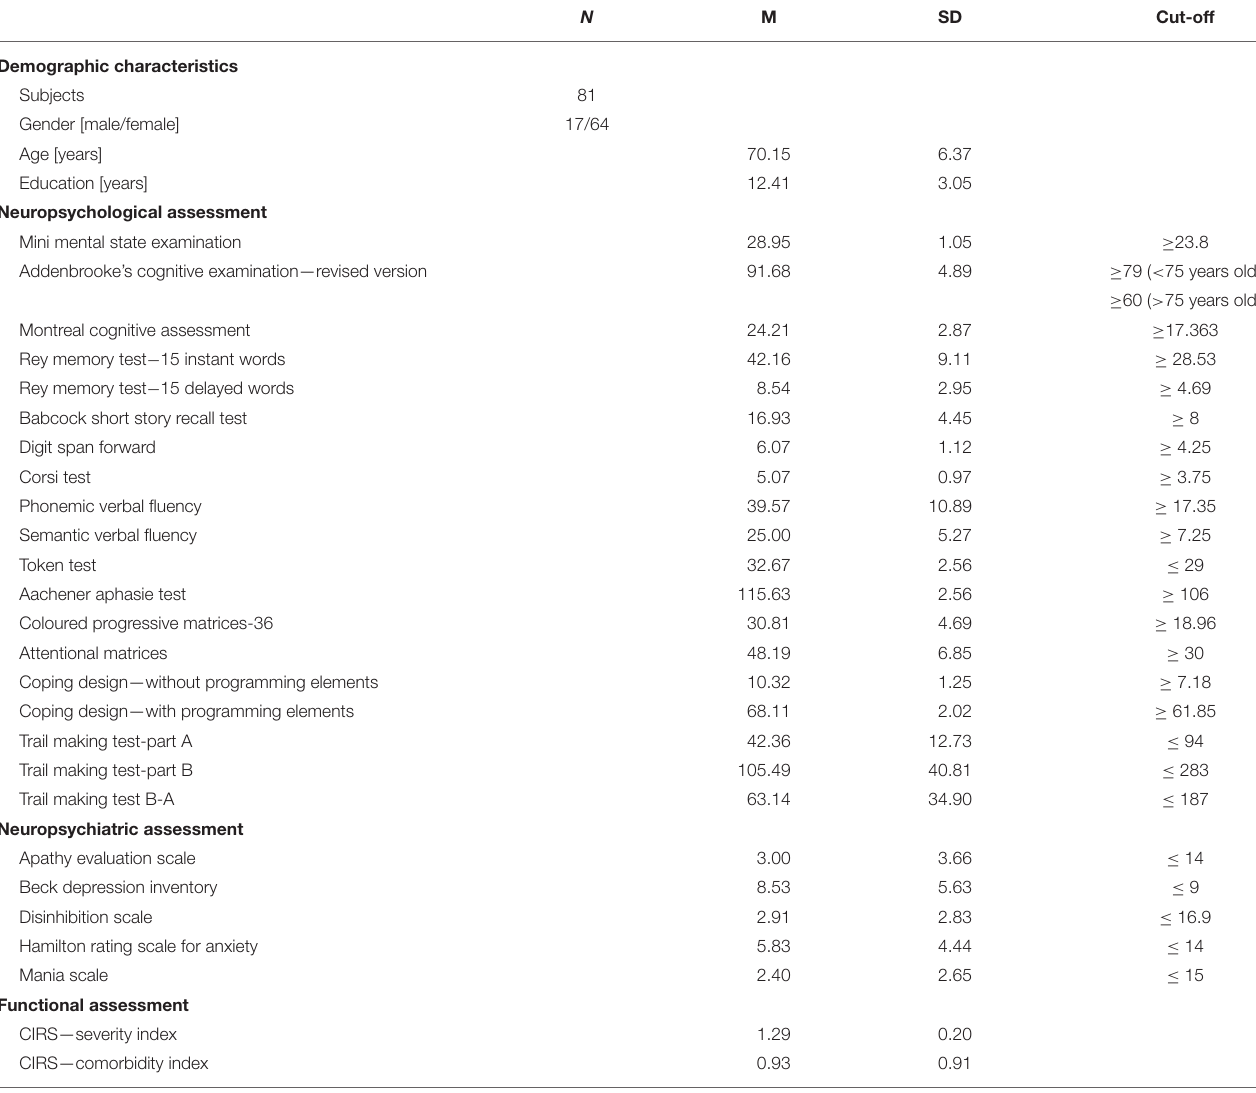
TABLE 1 | Demographic and neuropsychological characteristics (T0).